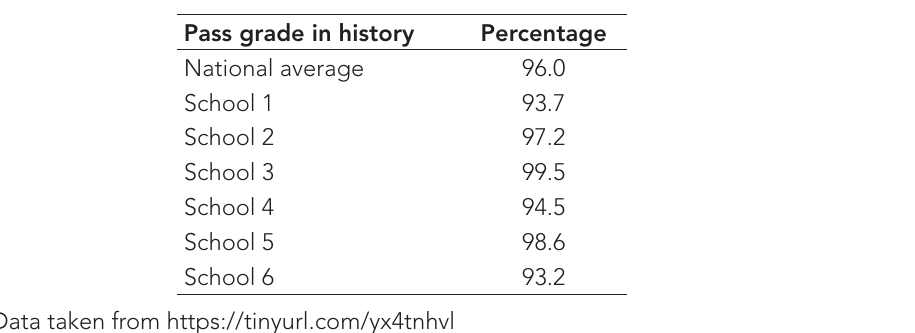
Table 1: Percentage of pass grades in history by